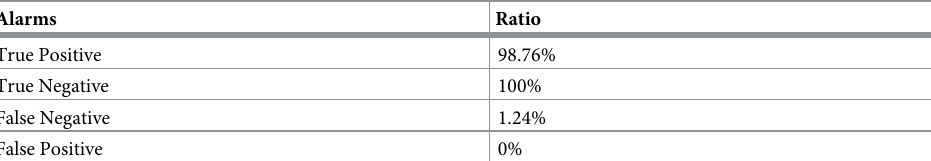
Table 5. Average alarm rate.